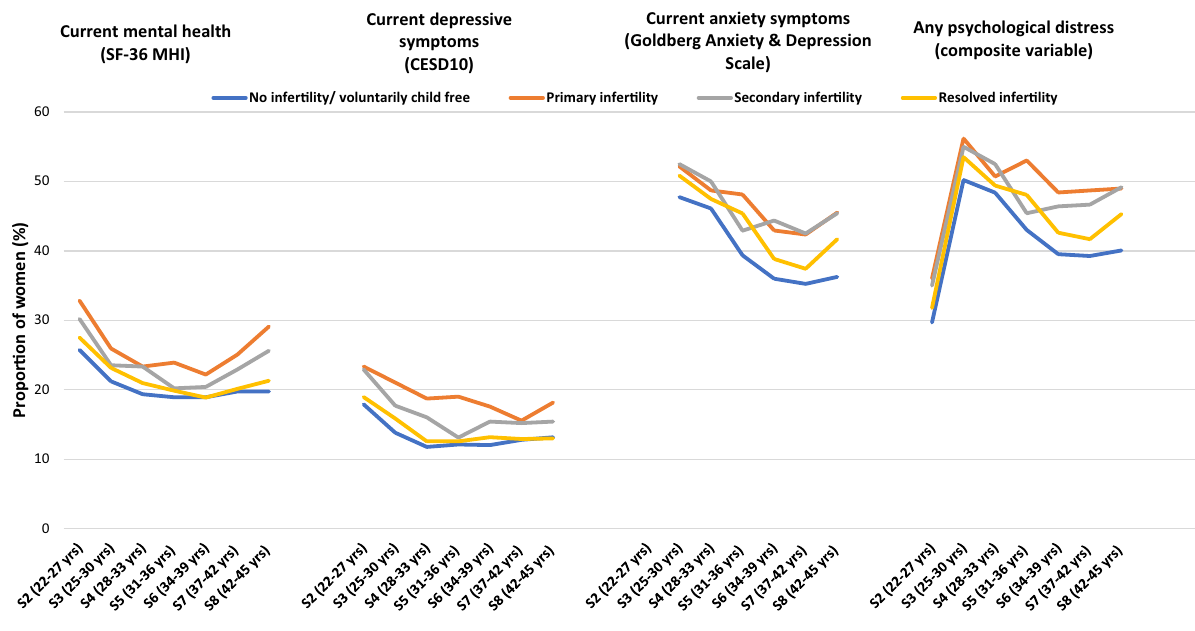
Figure 1. Proportion of 6580 women reporting poor mental health, anxiety, depression and any psychological distress at each survey, according to the fertility